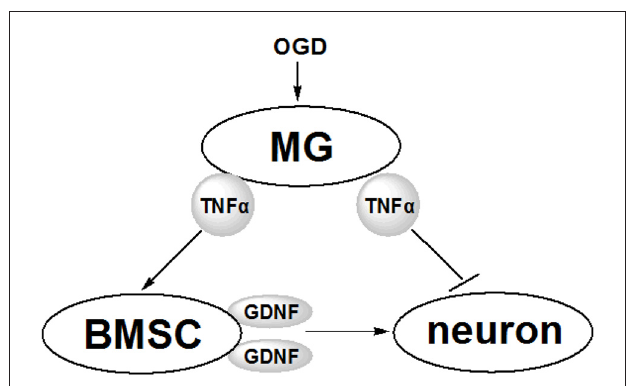
FIGURE 7 | Schematic diagram of the effects of MG and BMSC on neurons revealed in this study. Following the stimulation by OGD, MG secretes TNF α , which further induces BMSCs to produce more GDNF. GDNF protects neurons against OGD-induced injury. Furthermore, TNF α secreted from MG induces inflammatory responses to suppress OGD-induced neuronal